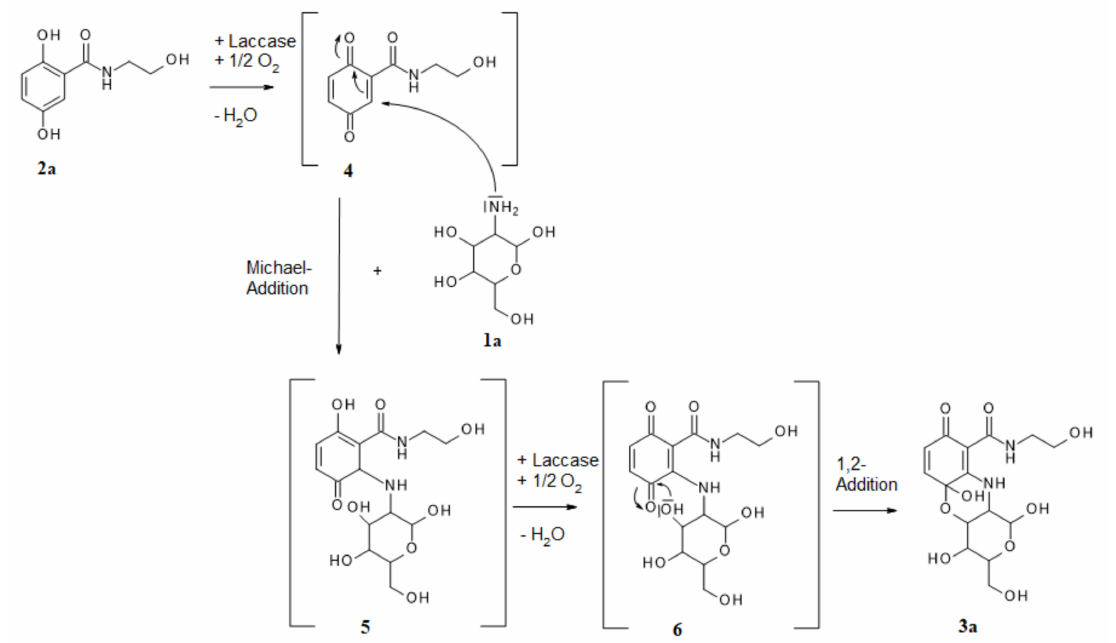
Figure 3. Possible reaction mechanism of laccase-mediated reaction for the synthesis of product 3a